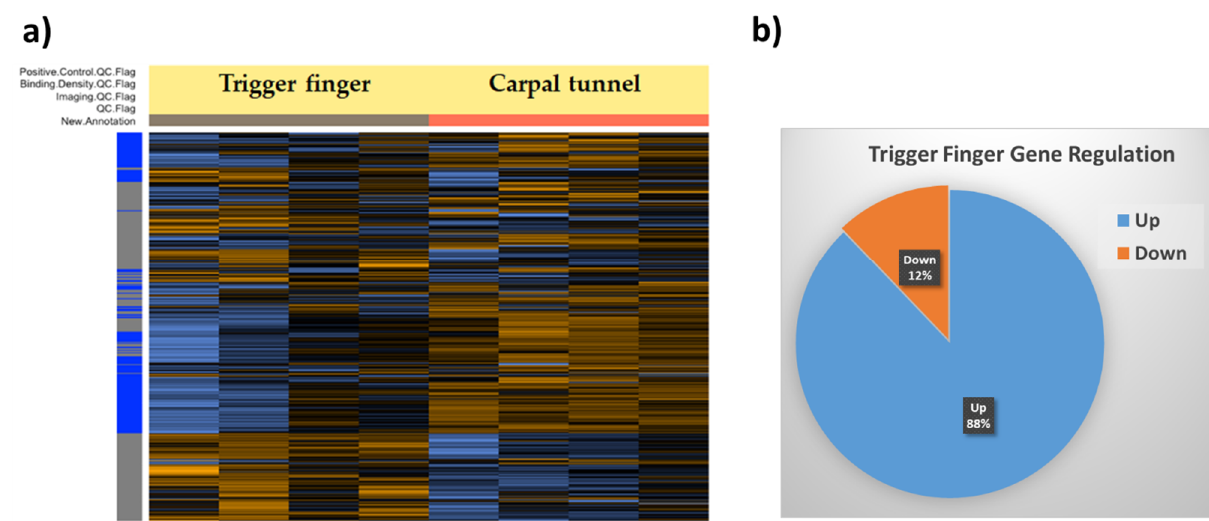
Figure 1. ( a ) Heatmap of normalized data generated via unsupervised clustering by the Nanostring nSolver software. Heatmap is scaled to give all genes equal variance. Control samples ( n = 4) are organized under the orange column, and trigger finger samples ( n = 4) are organized under the gray column. Within the gene clusters, orange indicates high expression, and blue indicates low expression. ( b ) Pie chart showing the percentage of genes up- and downregulated in trigger finger compared to carpal tunnel